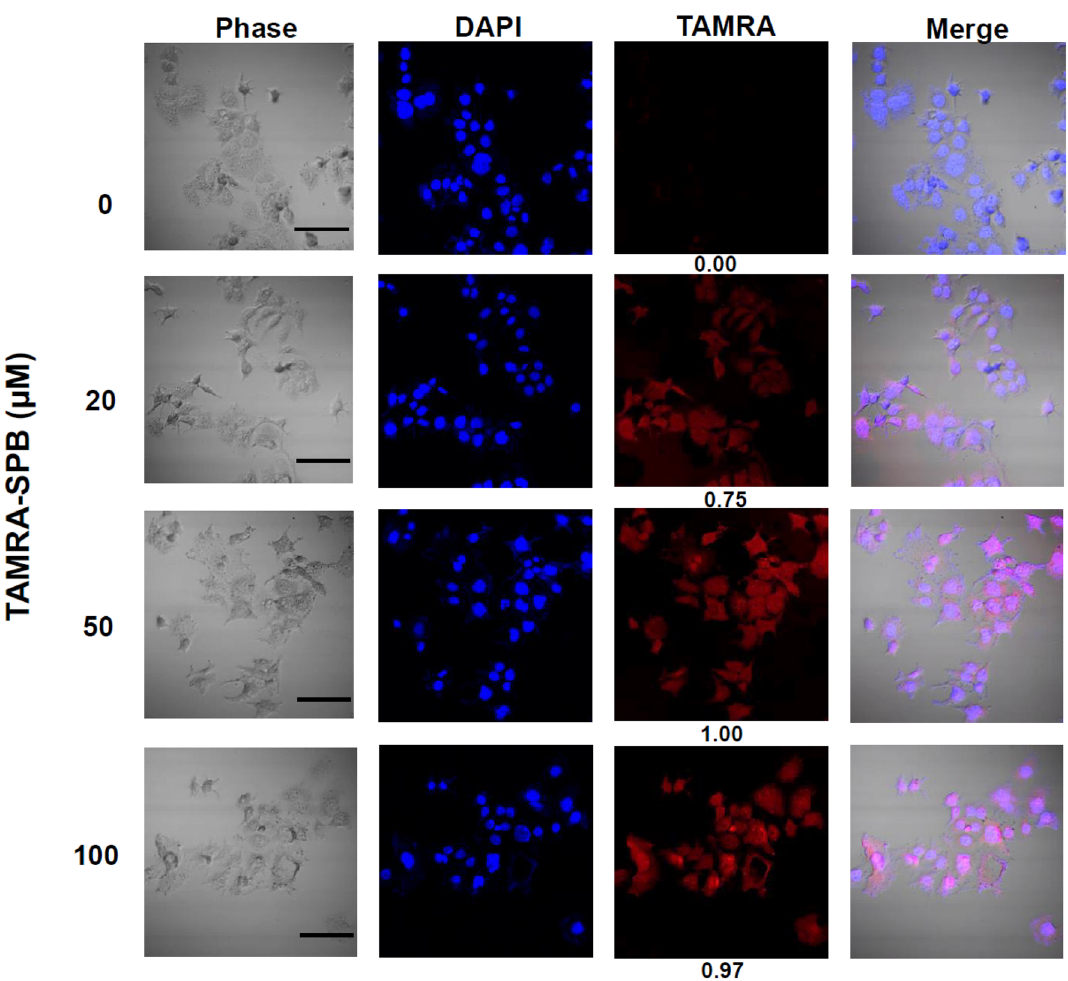
Figure 1. Binding of the bladder cancer-specific peptide (SPB) to HT-1376 bladder cancer cells. The SPB was conjugated with the fluorescent dye TAMRA to form a TAMRA-SPB conjugate, and the binding of TAMRA-SPB to bladder cancer cells was determined by detection of red fluorescence using a confocal microscope. Scale bar: 100